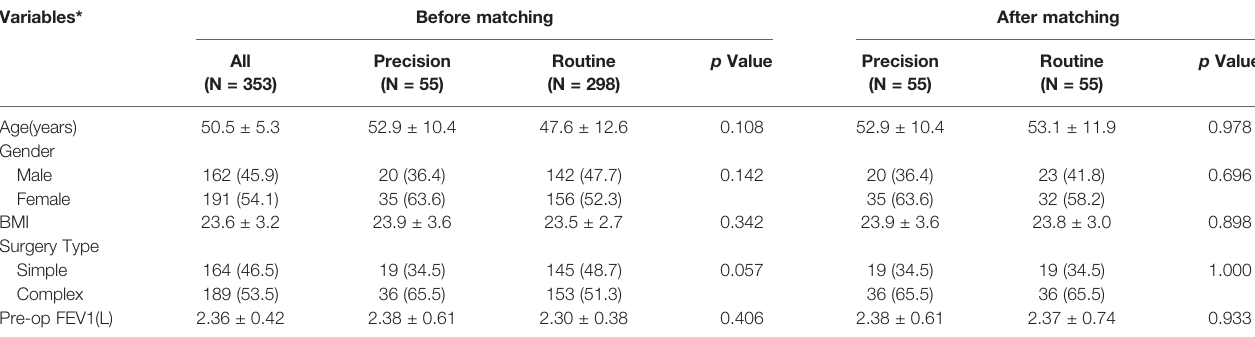
TABLE 1 | Demographic data of precise and routine VATS uniportal segmentectomy.